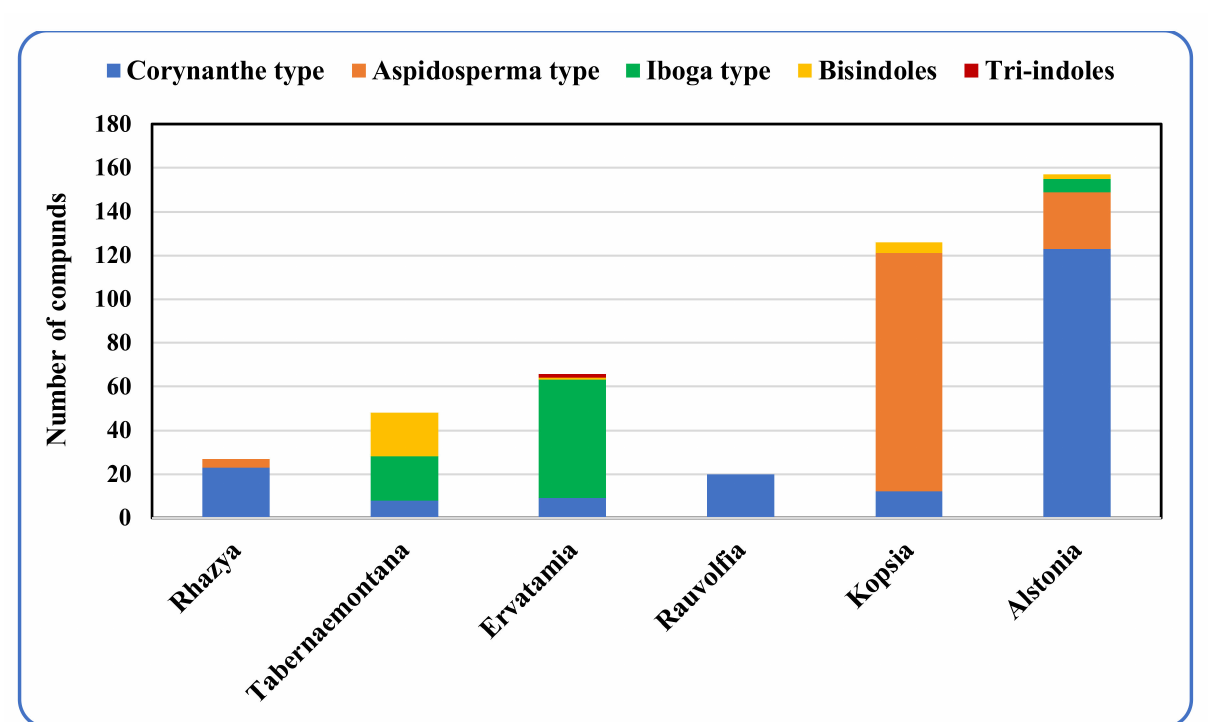
Figure 3. The types of the structures identified monoterpenoid alkaloids from the six genera. Additionally, the future prospective and emphasizing the research gaps and highlight- ing the roadmap to discover the potent bioactive monoterpenoid alkaloids, which could be a drug lead from the six genera. Also, this review will discuss the reported structural activity